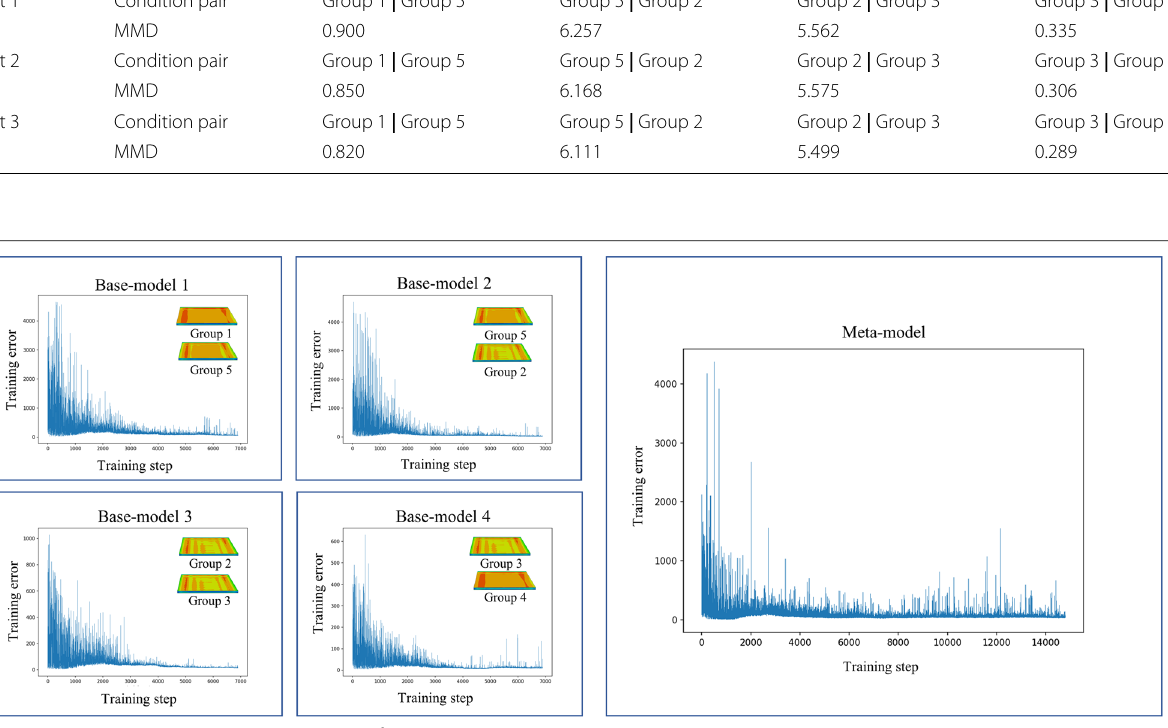
Fig. 9 Convergence curves in training process of Part